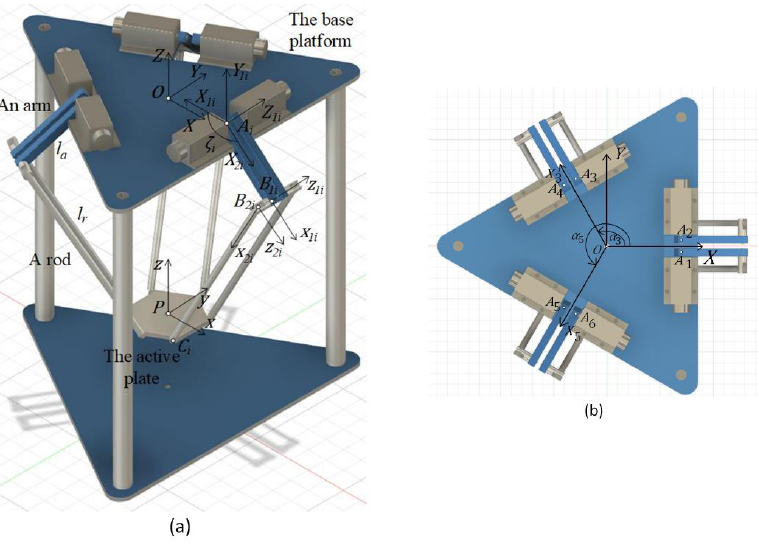
Figure 1. The model of the Hexa robot: ( a ) in 3D view, ( b ) in top view. The point P representing the end-effector and the Euler angles ( φ , θ , ψ ) of the active plate with respect to the fixed frame { O } are given. Three angles ( φ , θ , ψ ) are defined in compliance with the intrinsic rotation convention of Euler angles. The coordinate with respect to the active frame { P } can be transformed to the coordinate with respect to the fixed frame { O } by using the rotation matrix R O P